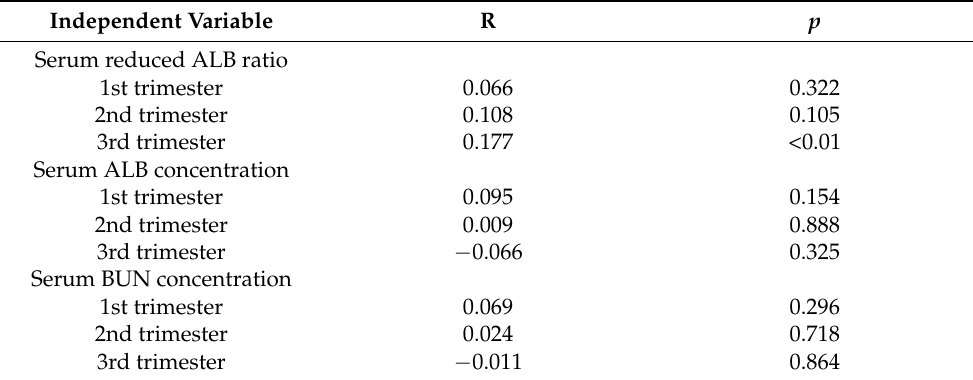
Table 2. Simple linear regression analyses of serum biochemistry vs. infant birth weight in preg- nant women. Independent